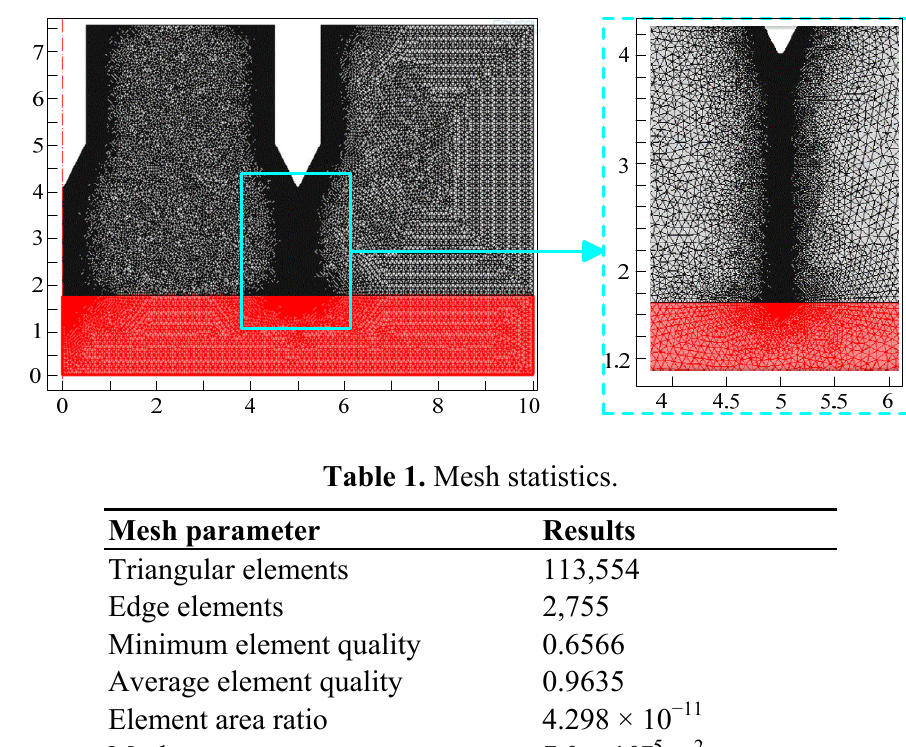
Figure 3. Computational domain of 2-D model in an unstructured triangular grid (units in millimeters).